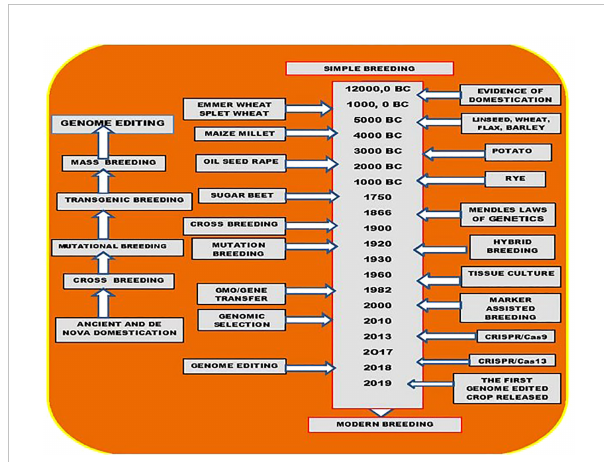
FIGURE 4 Plant breeding milestones. The start of domestication and initial plant breeding dates back around 12,000 B.C. when the living style of Human-being changed from gathering and hunting to agriculture. The fi rst-ever domesticated plant was emmer wheat. Since then, ancient domestication and selective breeding were dominant until the discovery of Mendel ’ s laws of genetics. The laws of genetics triggered and enhanced the crossbreeding wave. A milestone in plant breeding that plays an essential role in modern plant breeding was the invention of the totipotency of plant cells in the early 1900s by Gottlieb Haberlandt. As a result, the fi rst in vitro tissue culture was introduced in 1960 with carrots. Plant tissue culture was the critical step for generating the fi rst Agrobacterium-mediated transgenic tomato in 1994, known as transgenic breeding. In the meantime, mutational breeding using chemical or physical agents was also introduced in the 1930s and played an important role in generating diverse genetic materials for crop breeding. Biochemical markers further enhanced crossbreeding in marker-assisted selection (MAS) breeding. The recently emerging genome editing approaches have revolutionized plant breeding to precision levels that have never been obtained before. High oleic acid soybean, the fi rst genome-edited crop that was released in 2019, has been opening the wave of genome-edited precision breeding in